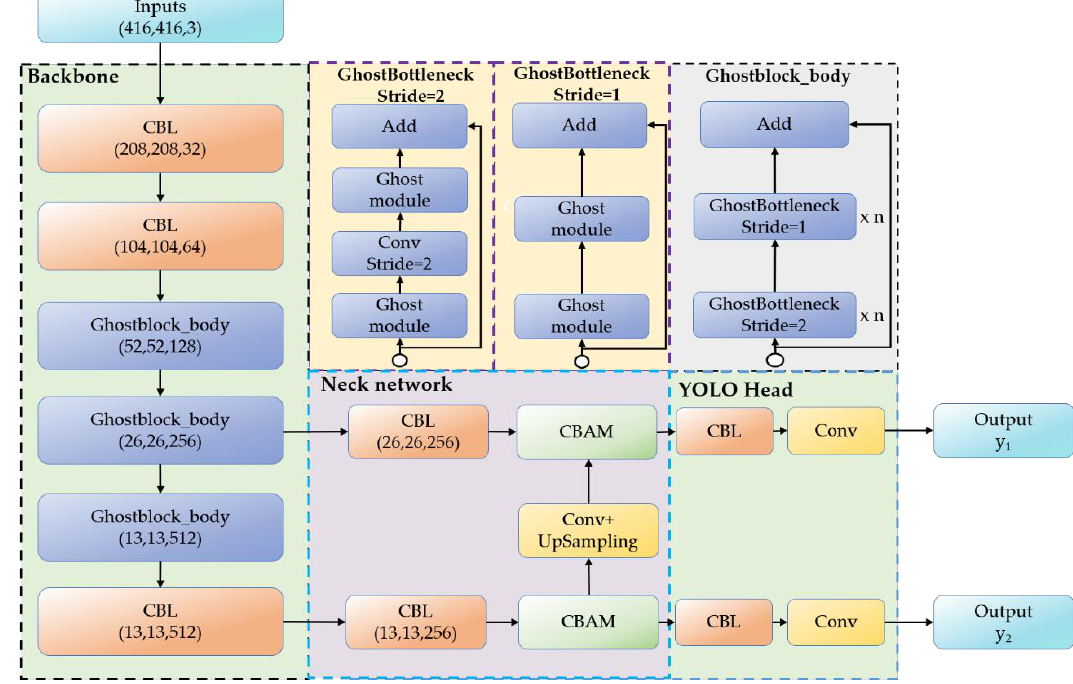
Figure 2. The network structure of YOLOV4-Tinier.